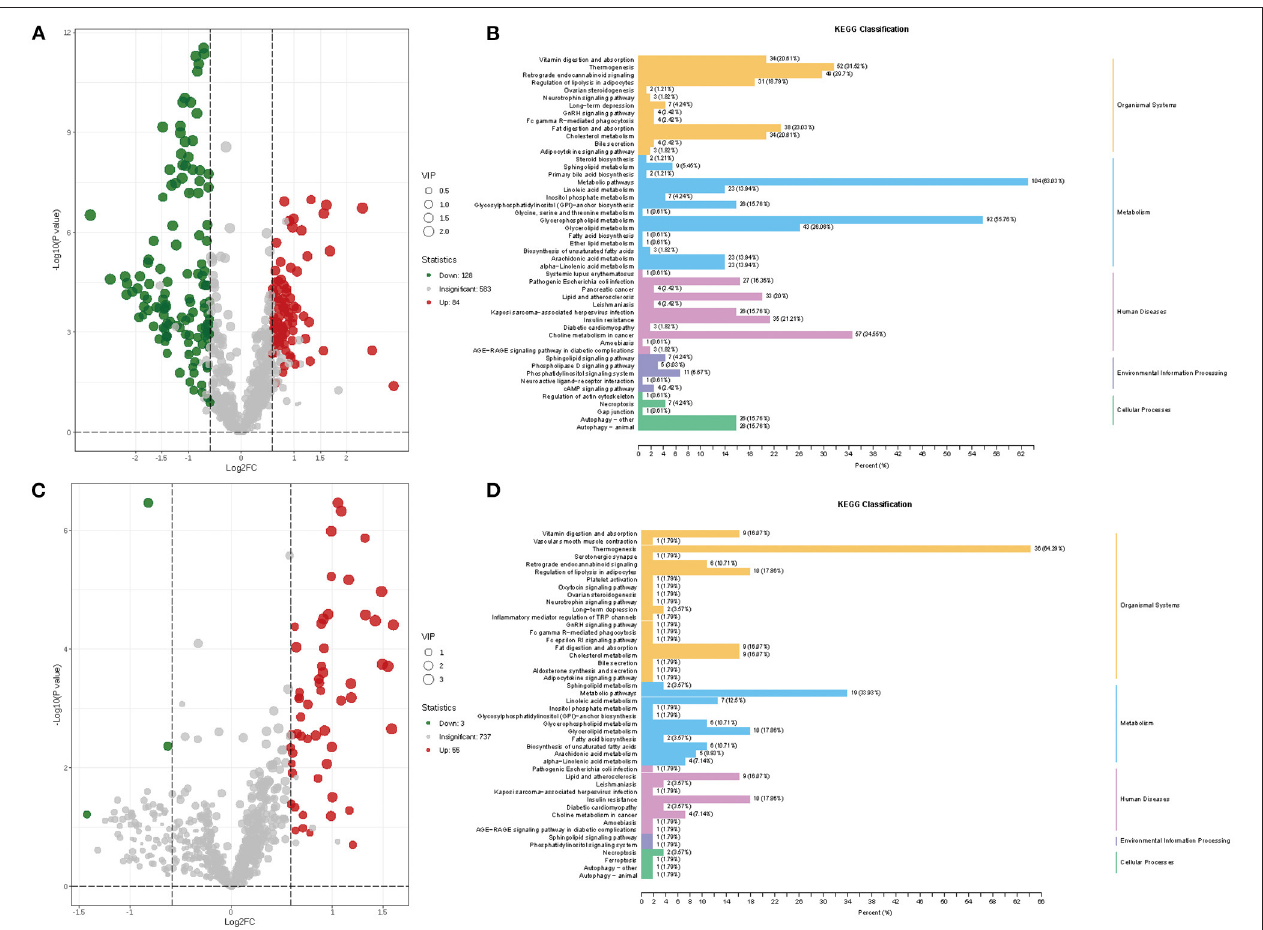
FIGURE 3 | Screening and enrichment analysis of differential lipid metabolites. (A) Volcano plot showing differential lipid metabolites between AMI and HC. (B) KEGG enrichment analysis for differential lipid metabolites between AMI and HC. (C) Volcano plot showing differential lipid metabolites between AMI and UA. (D) KEGG enrichment analysis for differential lipid metabolites between AMI and